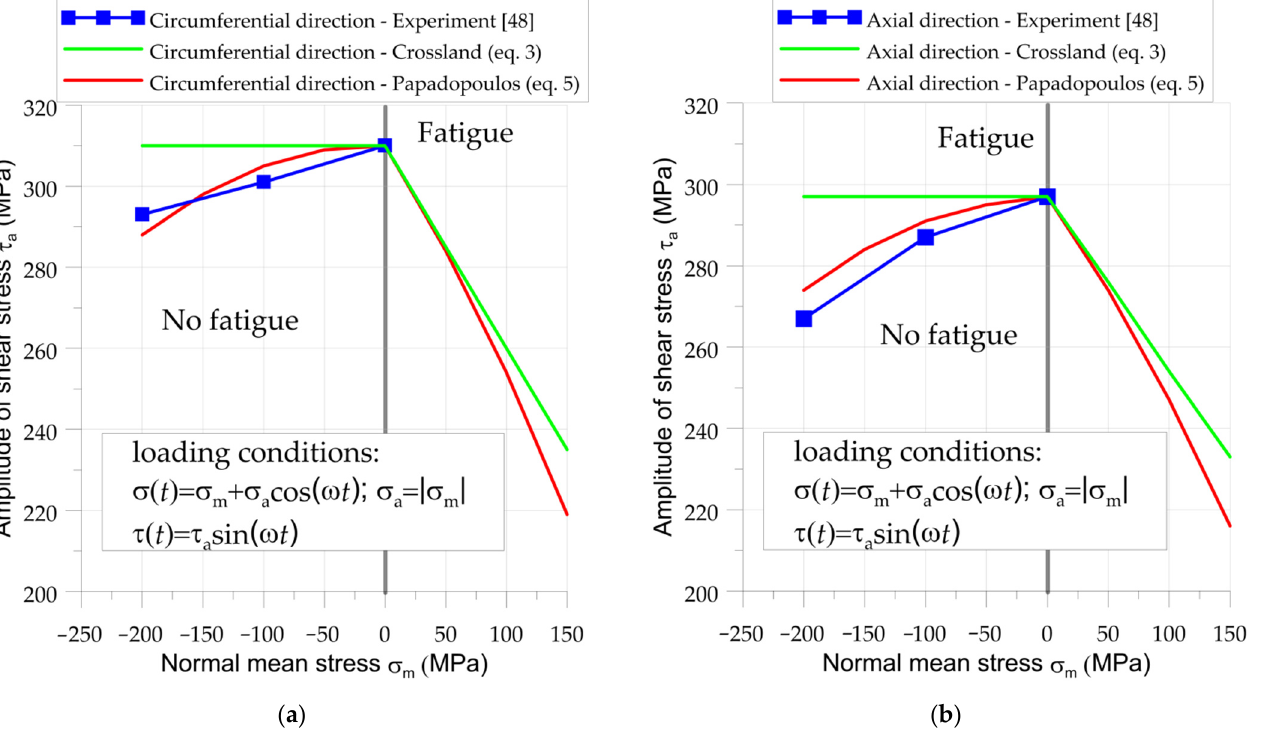
Figure 6. Comparison of results obtained from Crossland and Papadopoulos criteria, with experimental tests for samples extracted from railway wheel made of R7T steel: ( a ) samples cut in circumferential direction; ( b ) samples cut in axial direction. Experimental results are taken from Ref [48].